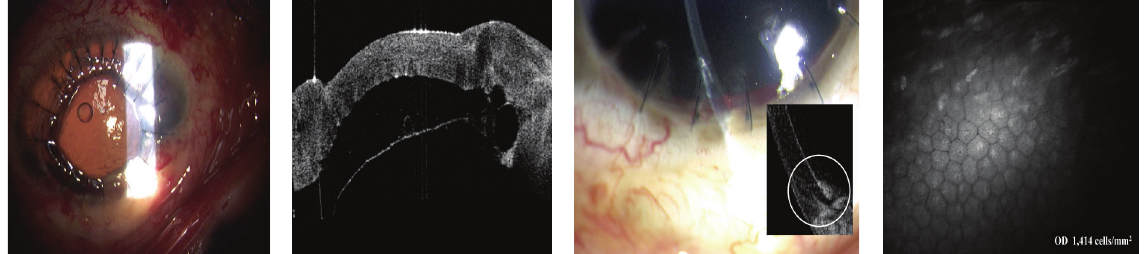
Figure 13: Aphakic eye with corneal graft and intraocular silicone